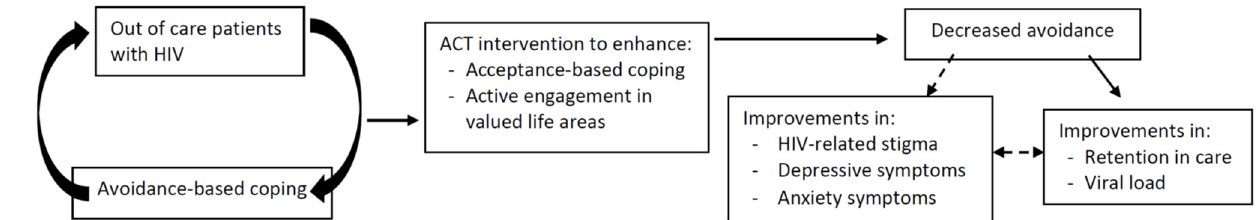
Figure 2. Conceptual model.